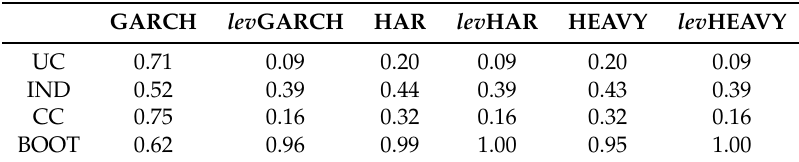
Table 1. p -values of the Unconditional Coverage (UC), Independent violations (IND) and Conditional Coverage (CC) tests of Christoffersen (1998) on the VaR predictions, and of the bootstrap test (BOOT) on the ES predictions. Rejections at the 5% level are in bold.